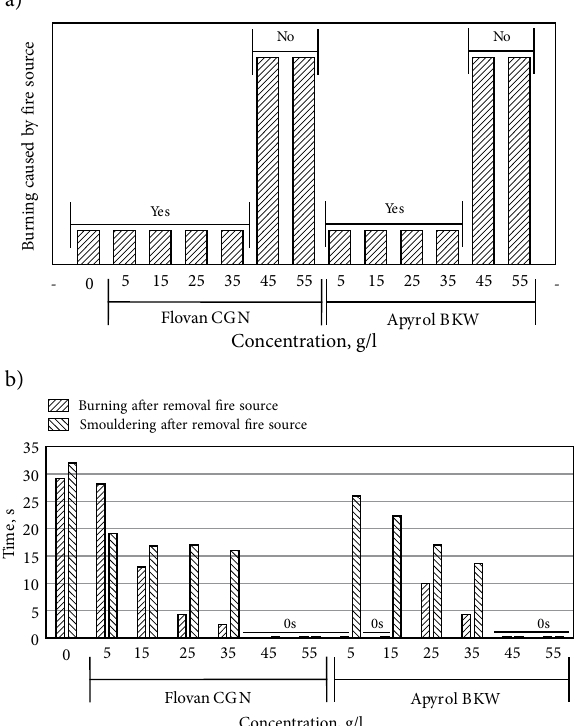
Fig. 6. Flamability of hemp fibre composite: a) burning caused by fire source; b) burning and smoldering time after removal